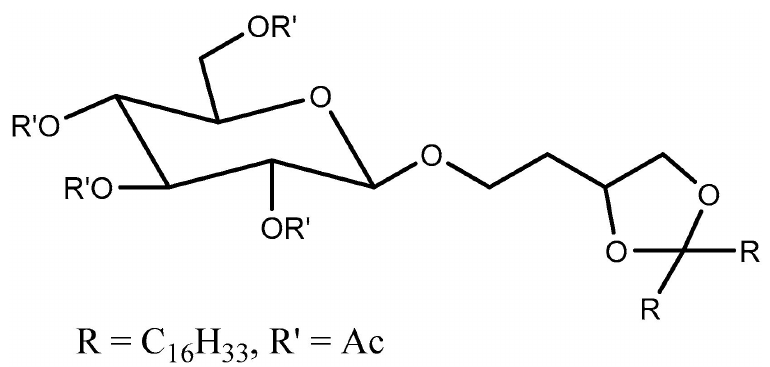
Figure 8. pH-sensitive acetal-based glycolipid [90].